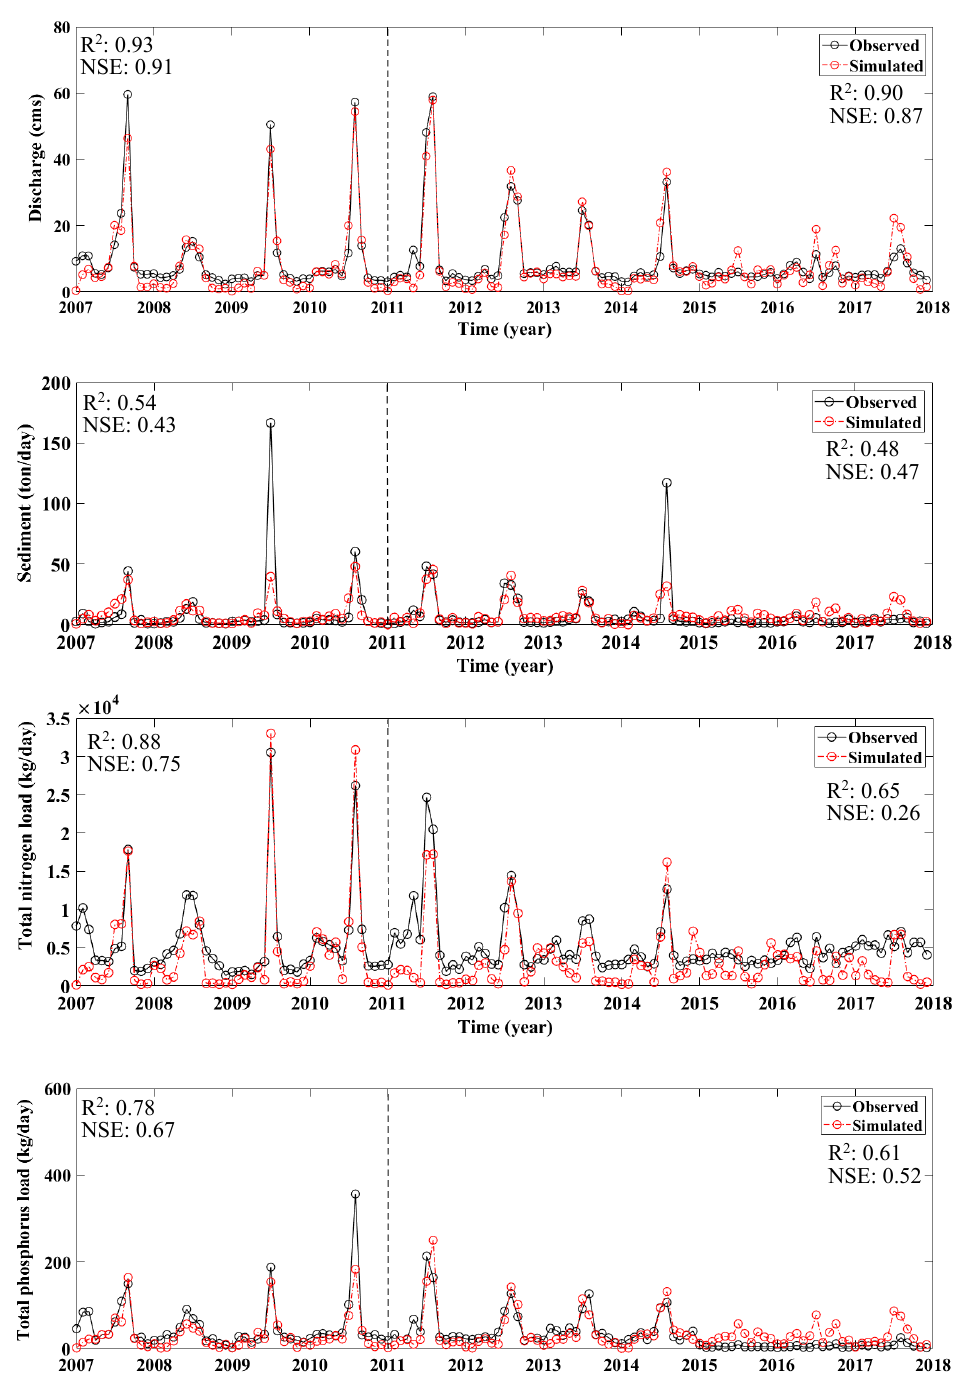
Figure 6. Calibration and validation results of streamflow and water quality in Sub-Watershed-6.